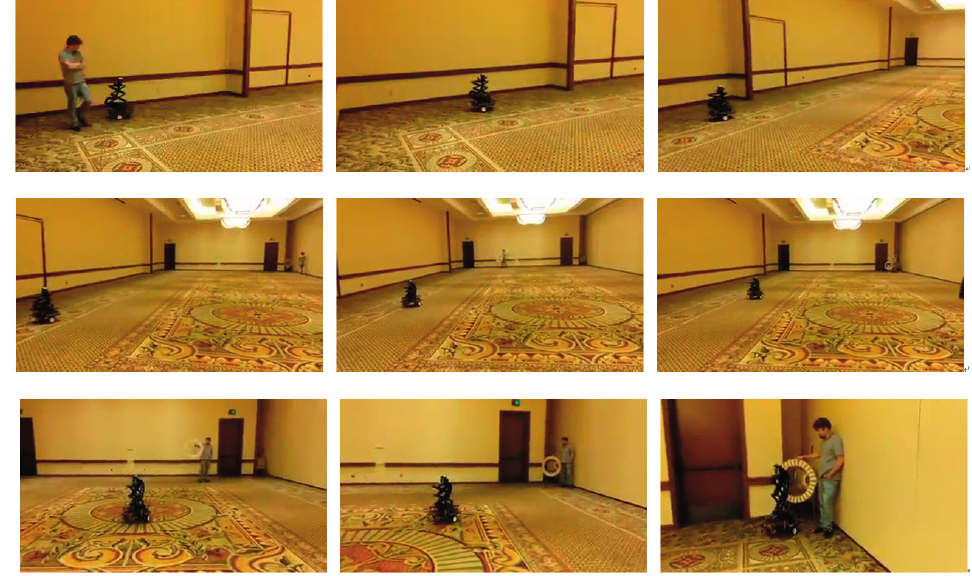
Figure 15. Autonomous aerial refueling ground test